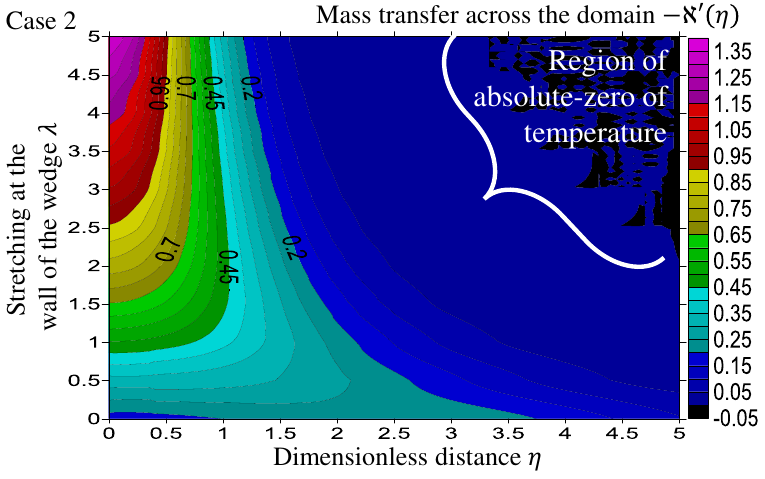
Figure 10. Variation of the gradient of distribution of motile gyrotactic organisms in the entire domain − χ (cid:48) ( η ) with the wall stretching velocity λ .